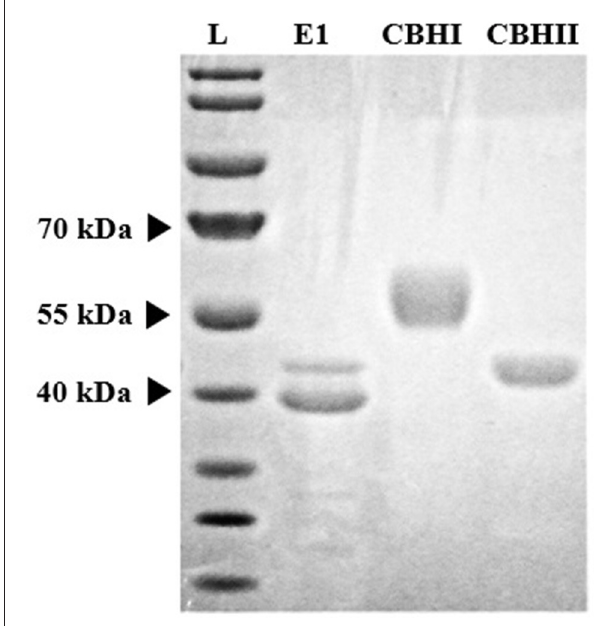
FIGURE 1 | Coomassie Blue stained SDS-PAGE gel of three recombinant cellulolytic enzymes purified from corn grain expression system. Lane L is the standard protein